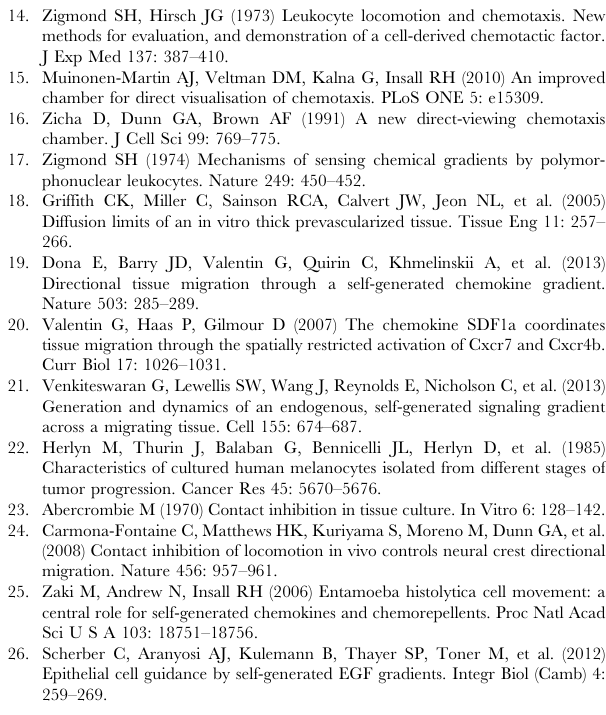
green dots. There is no visible difference in directional accuracy or speed between the cells with and without contacts. (PDF) Figure S2 Inhibition of LPA chemotaxis. (A) Serum chemotaxis is blocked by siRNA inhibition of LPAR1. Assays were performed exactly as in Figure 1G, using WM239A cells that had been transfected with a non-silencing RNA (left) or siRNA against LPA Receptor 1 (LPAR1; Qiagen flexitube GeneSolution, catalogue number GS1902; right). (B) LPA chemotaxis is blocked by LPA receptor antagonists. WM1158 cells were assayed as described for Figure 4D, in the presence of the LPAR1/3 antagonist Ki16425 (right panel) or a comparable amount of ethanol vehicle (left panel). (PDF) Figure S3 3-D organotypic assay performed while collagen plugs remained submerged in medium. The cell line WM98-1 that is highly chemotactic towards serum in 3-D organotypic assays, fails to perform chemotaxis if the gels are kept submerged throughout the 14 day assay period, despite growing on top of the plug. (PDF) Movie S1 Outward migration of densely packed mela- noma cells in the absence of a gradient. Both wells are filled with complete medium containing 10% FBS, but WM239A cells are only inoculated in the left well. See Figure 1A for details. Time stamps and scale bar are shown for reference. (MOV) Movie S2 Outward migration is not dependent on contact inhibition. See Figure 1D for details. WM1158 cells chemotax equally effectively whether or not they are contacting their neighbours. Time stamps and scale bar are shown for reference.